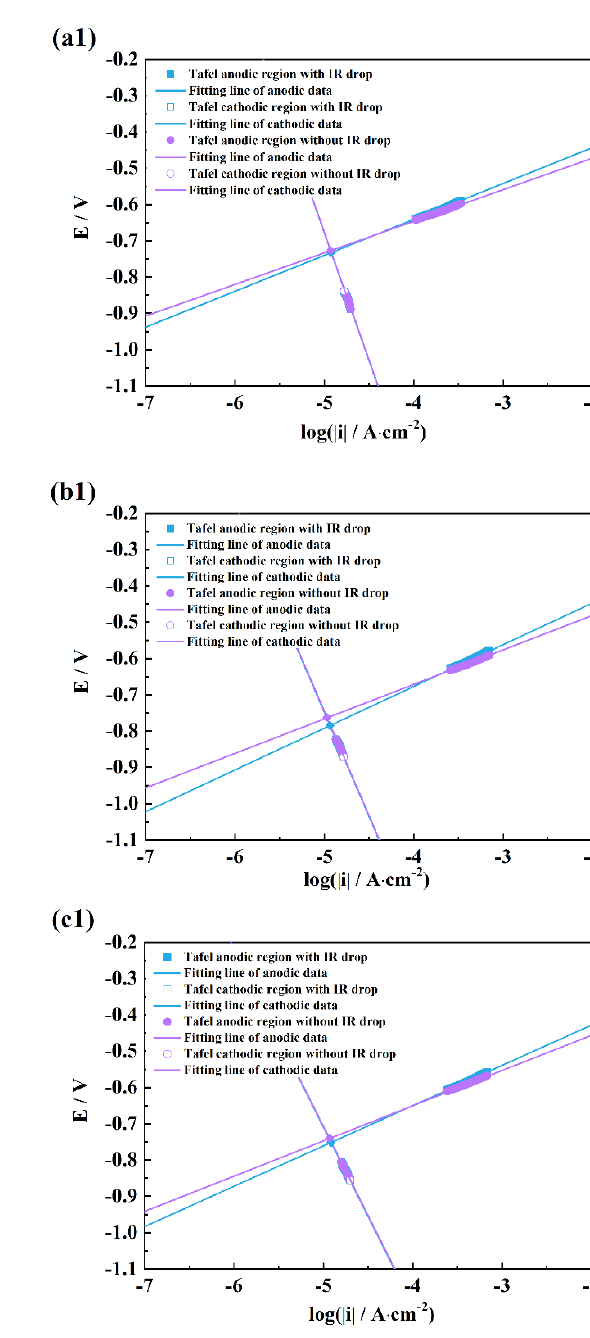
Figure 5. Comparison of polarization curves with and without an IR drop of M1 ( a ), M2 ( b ), M3 ( c ) and linear fitting plots of the Tafel regions of M1 ( a1 ), M2 ( b1 ), M3 ( c1 ) in H 2 SO 4 solutions after 2h exposure.